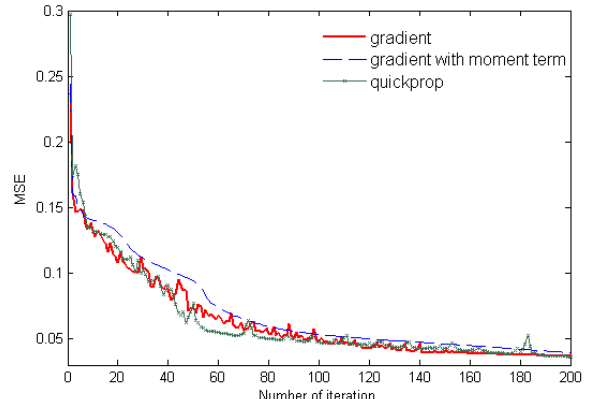
Figure 4. The performance (MSE) of three back-propagation algorithms